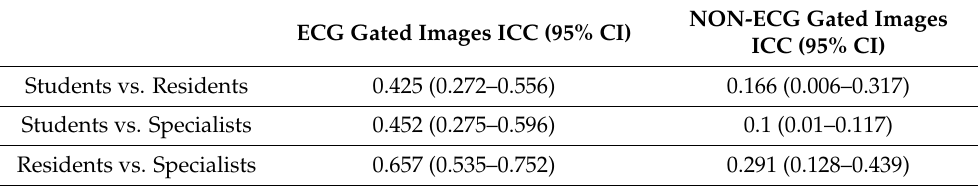
Table 3. Inter-rater reliability when comparing reporters with different training levels (students, residents, and specialists).